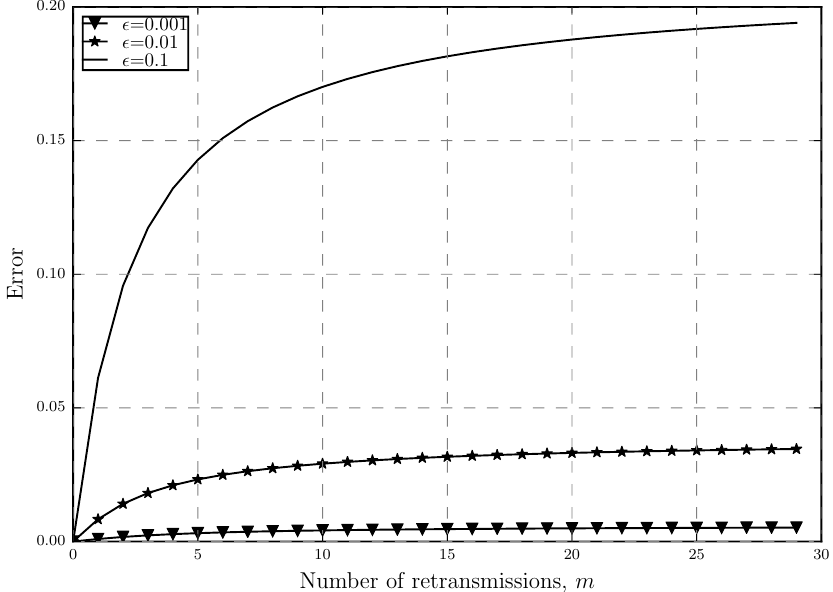
Figure 4. Error between the approximated and original average number of retransmissions 1 + ¯ m versus the number of retransmissions with different outage threshold (cid:101) levels.